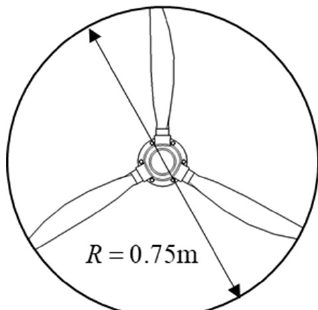
Figure 14. Vahana A 3 tilt-wing and the propeller used. Table 1. Mission profile parameters.